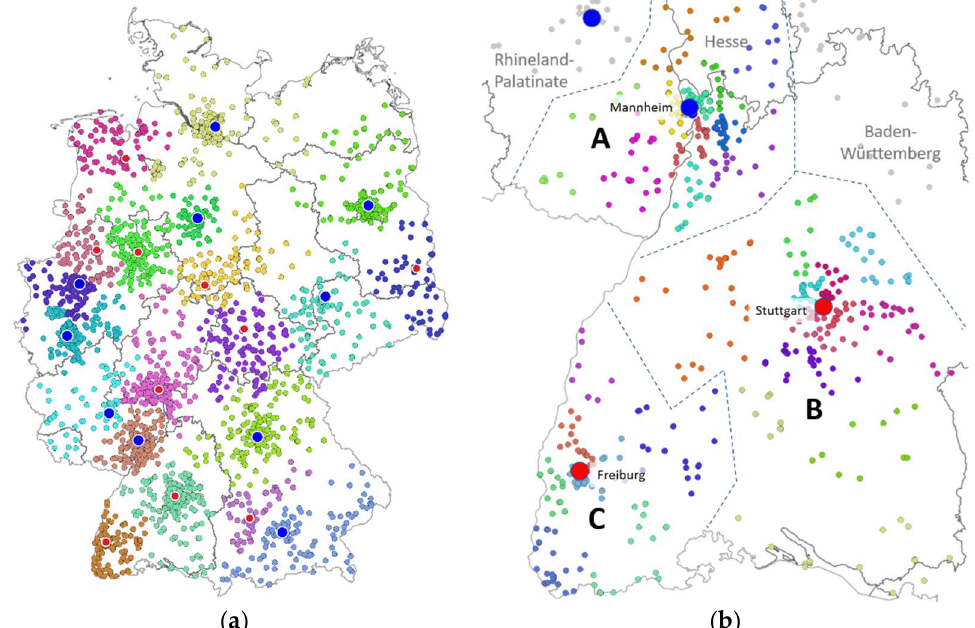
Figure 2. Last-mile analysis for the distribution of mRNA vaccines in Germany in 2021. ( a ) Hub locations and assignments of pharmacies to wholesaler hubs in Germany (simulation result for one wholesaler). Blue: vaccine receipt-points, red: intermediary distribution hubs. ( b ) Pharmacies organized in delivery clusters: simulated example for three hub areas A, B, C of one wholesaler in southwest Germany (Baden-Württemberg, Rhein-Neckar area and Palatinate).